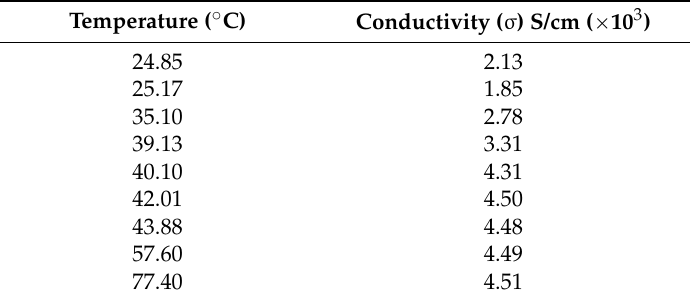
Table 2. The conductivity values of carbonized PAN fibers at 850 ˝